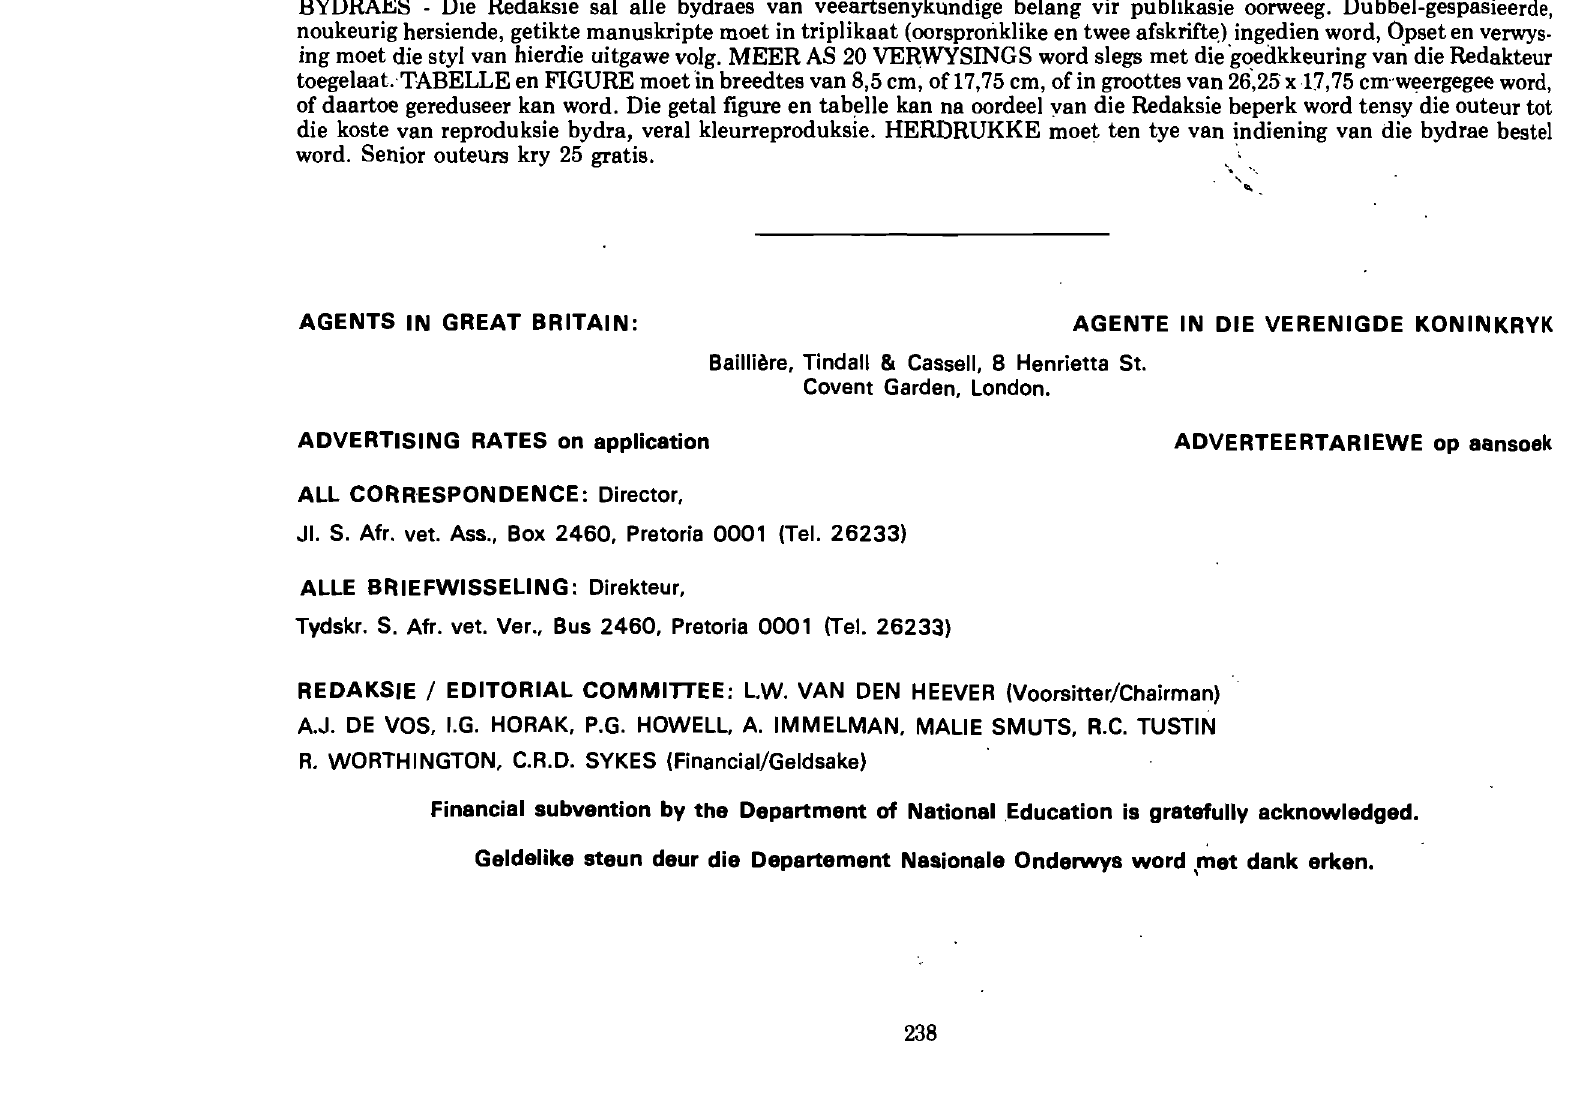
Die TYDSKRIF is die offisiele mondstuk en eiendom van en word gepubJiseer deur die Suid-Afrikaanse Veterinere Vereniging. Dit verskyn kwartaalliks en word aan sake van algemene veeartsenykundige belang gewy. Bydraers tot hierdie Tydskrif maak hul stellings en lug hul menings slegs op eie verantwoordelikheid; sodanige stellings word nie noodwendig deur die Redaksiekomitee onderskryf nie en die menings gee nie noodwendig die Komitee se menings weer nie. Kopeireg word op al die letterkundige inhoud van die Tydskrif voorbehou. INTEKENING - 'n Eksemplaar van elke uitgawe word gratis aan aile volwaardige lede van die Vereniging gestuur. Die in tekengeld vir persone wat nie Ie de is nie beloop R12,50 per jaar, posvry per land- of seepos. VORIGE UITGAWES R4,OO/eksemplaar.